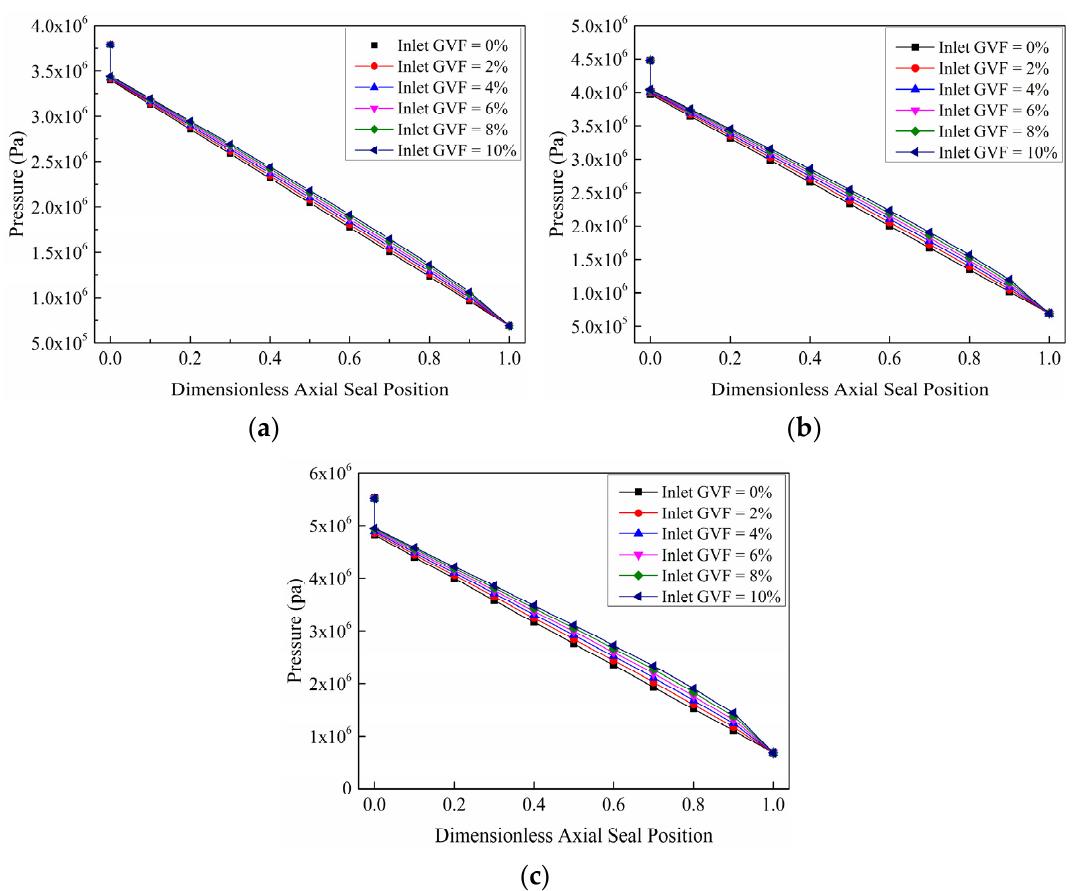
Figure 8. Pressure profile along the axial direction under different inlet GVFs. ( a ) Δ P = 31 bars, ( b ) Δ P = 37.9 bars, ( c ) Δ P = 48.3 bars.